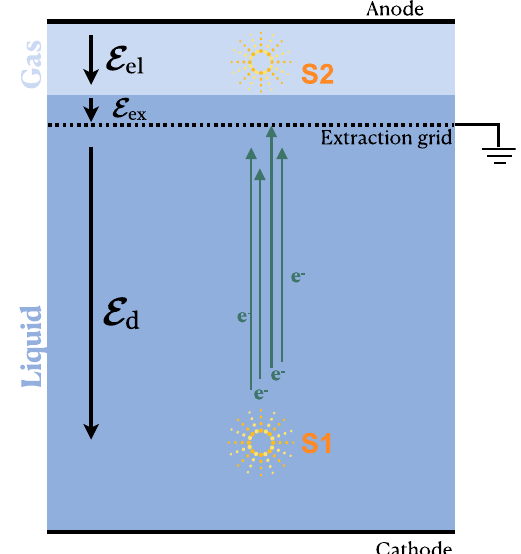
Fig. 1 Conceptual sketch of the working principle of a double-phase argon TPC, illustrating a typical event with both a primary scintillation signal (S1) and a secondary electroluminescence signal (S2), whose intensity is proportional to the ionization charge. The electric field in three different regions of the TPC, indicated here as the drift field ( E d ), extraction field ( E ex ) and electroluminescence field ( E el ), is responsi- ble for drifting free ionisation electrons towards the extraction grid, extracting them into the gas phase, and producing the electrolumines- cence signal in the gas,